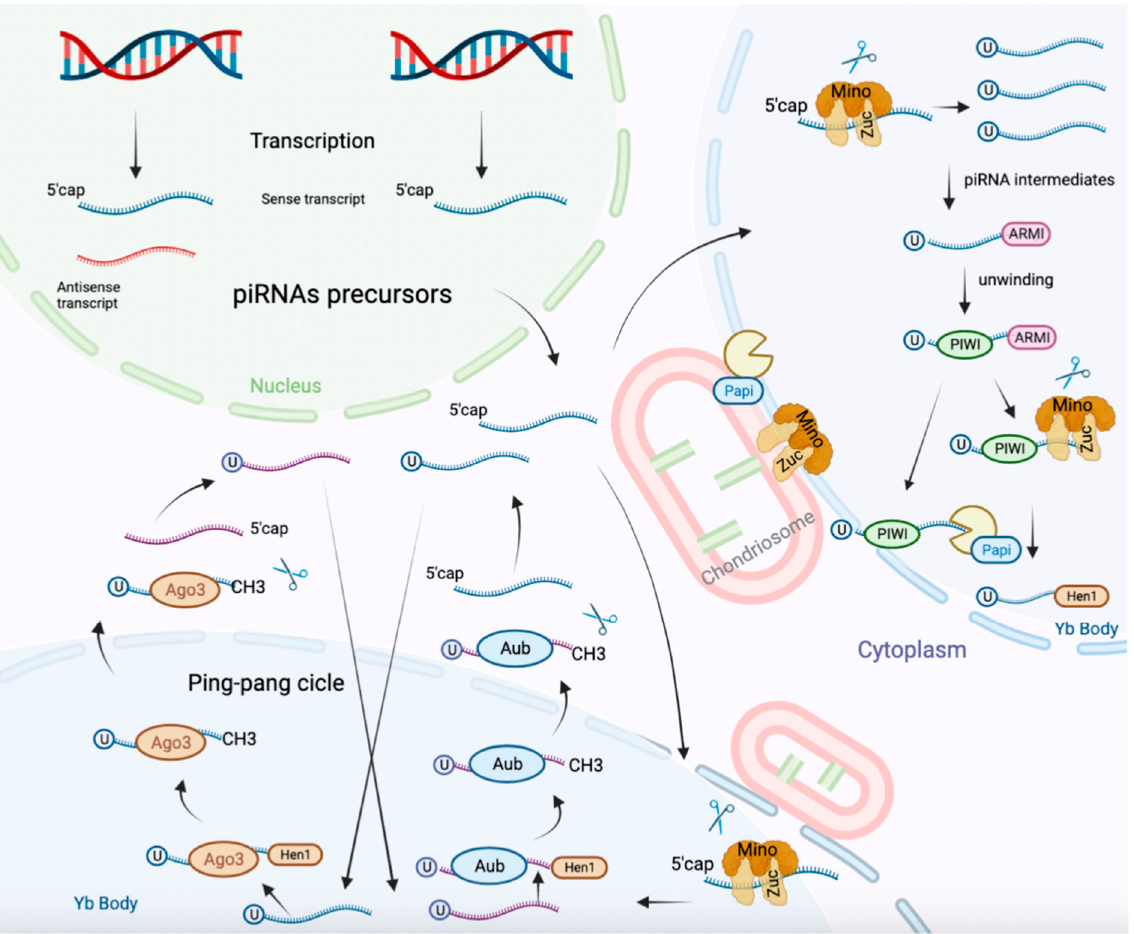
Figure 2. piRNAs synthesis and function. Mature piRNAs are generated from the processing of single-stranded RNAs transcribed from piRNA clusters in the genome, representing the largest class of non-coding RNAs found in most species. piRNAs can be also generated in the cytoplasm by a mechanism called the “ping-pong” cycle involving piRNA-directed antisense primary cleavage of transposon transcripts by Aubergine and PIWI proteins. piRNAs can modulate histone modifications and DNA methylation in a sequence-specific manner, leading to alterations in chromosomal conformation and gene expression regulation.